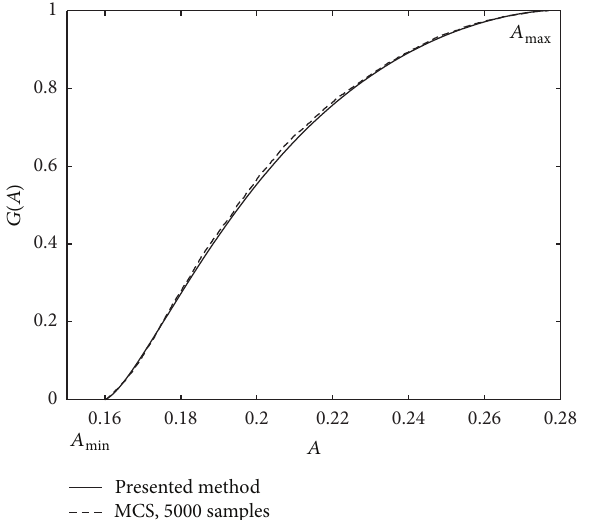
Figure 2: Distribution functions of 𝐴 obtained by the presented method and by MCS, respectively. Parameters are given as 𝑈 = 2𝑈 𝑓 , = 100 , and 𝛿 = 50 . 𝛿 0 1